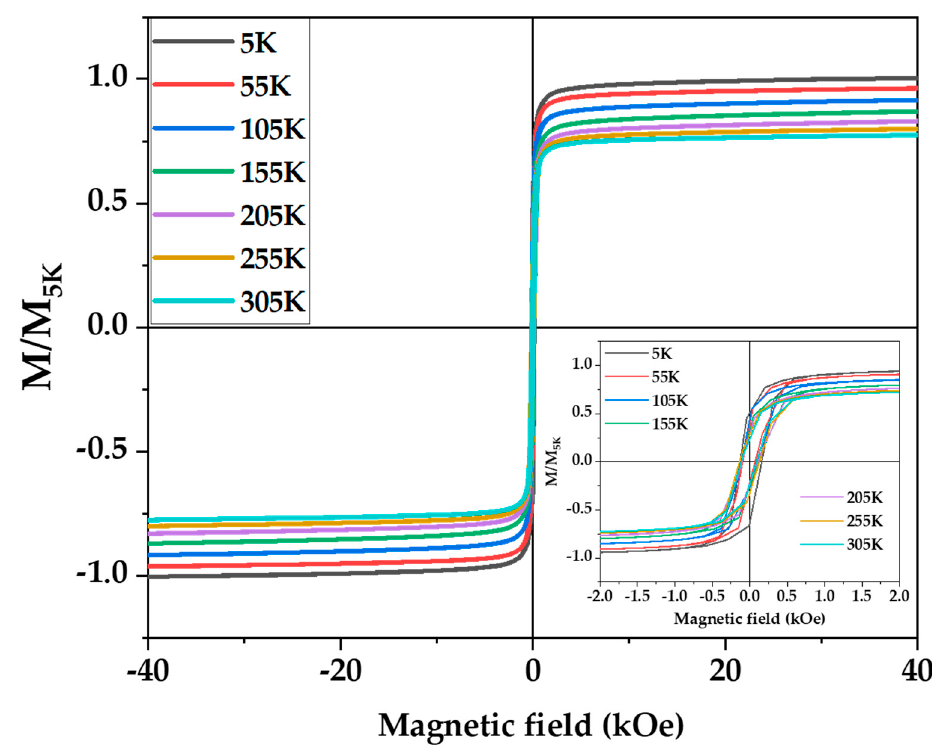
Figure 3. Magnetization curves M/M 5K (H) of the as-prepared Co 2 MnGe glass-coated microwires measured at a maximum field, ± 40 kOe, and a temperature range of 305 K to 5 K. Low field M/M 5K (H) loops are shown in the inset.